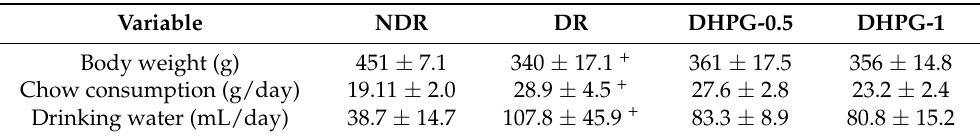
Table 1. Body weight and daily chow and water intake (mean ± standard deviation) of non-diabetic rats (NDR). Diabetic control rats (DR) and DR were treated with 3 (cid:48) ,4 (cid:48) -dihidroxifenilglicol (DHPG)